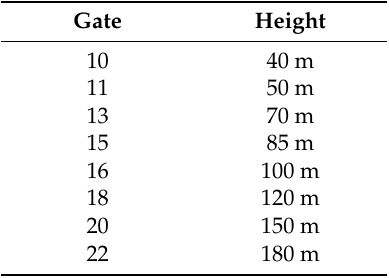
Table 2. Relationship between the gate and